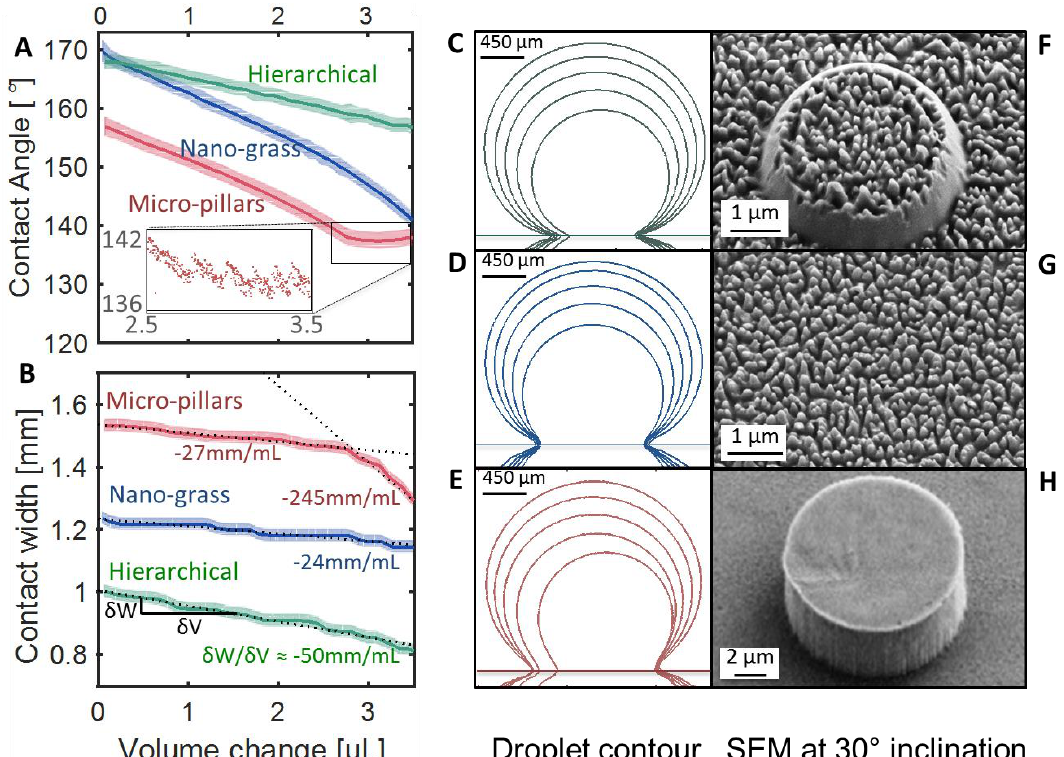
Figure 2. Results of the droplet evaporation experiments. A water droplet left on the PP surface for 30 min. ( A ) The water contact angle compared to the droplet evaporated volume for the three types of structures. Insert: zoomed in view of a part of the curve for the micro-pillar surface. ( B ) The contact diameter a) with respect to the evaporated volume 𝑉 . Each line is fitted with a linear fit. The fits are shown as black dotted lines. The slope values from the fits are written under each curve. ( C ), ( D ), ( E ) The contours of one droplet sitting on each of the three surfaces during the evaporation. ( F ), ( G ), ( H ) SEM micrographs of the surface structures for hierarchical, nano-grass, and micro-pillar samples, respectively. The images are taken at a 30 ◦ tilt angle, and each sample is coated with 10 nm Au for better imaging.